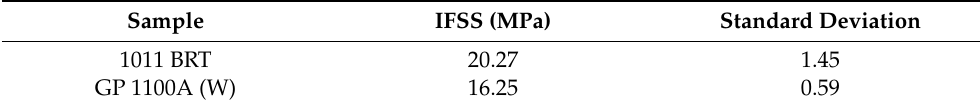
Table 4. IFSS calculation result and standard deviation of the GF and PA6 interface.